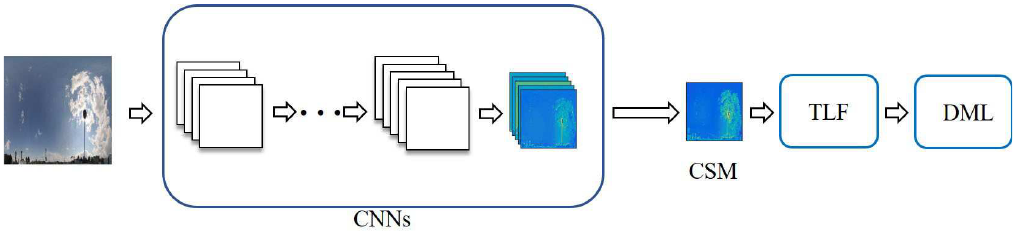
Figure 6. The architecture of the proposed method based on CNNs for cross-domain ground-based cloud